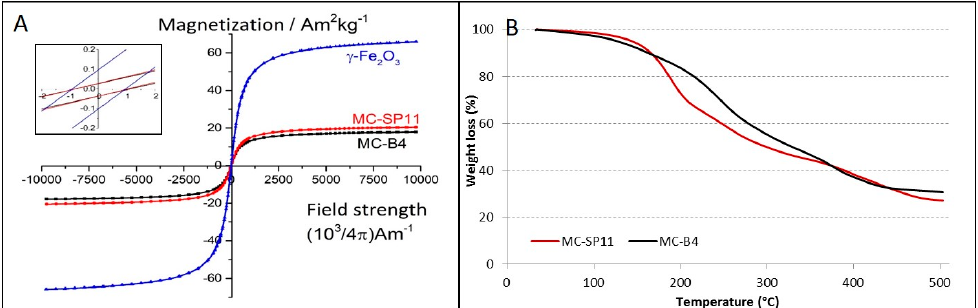
Figure 5. Magnetization as a function of magnetic field strength for the γ -Fe 2 O 3 nanocrystals, MC-B4 and MC-SP11 nanocarriers (as indicated), measured at room-temperature ( A ). The coercive field is ~1 Oe for all three types of nanostructures (see inset) while remanent magnetizations are ~0.1 Am 2 /kg and ~0.03 Am 2 /kg for γ -Fe 2 O 3 nanocrystals and both nanocarriers, respectively. TGA curves for the MC-B4 and MC-SP11 composite nanocarriers ( B ).